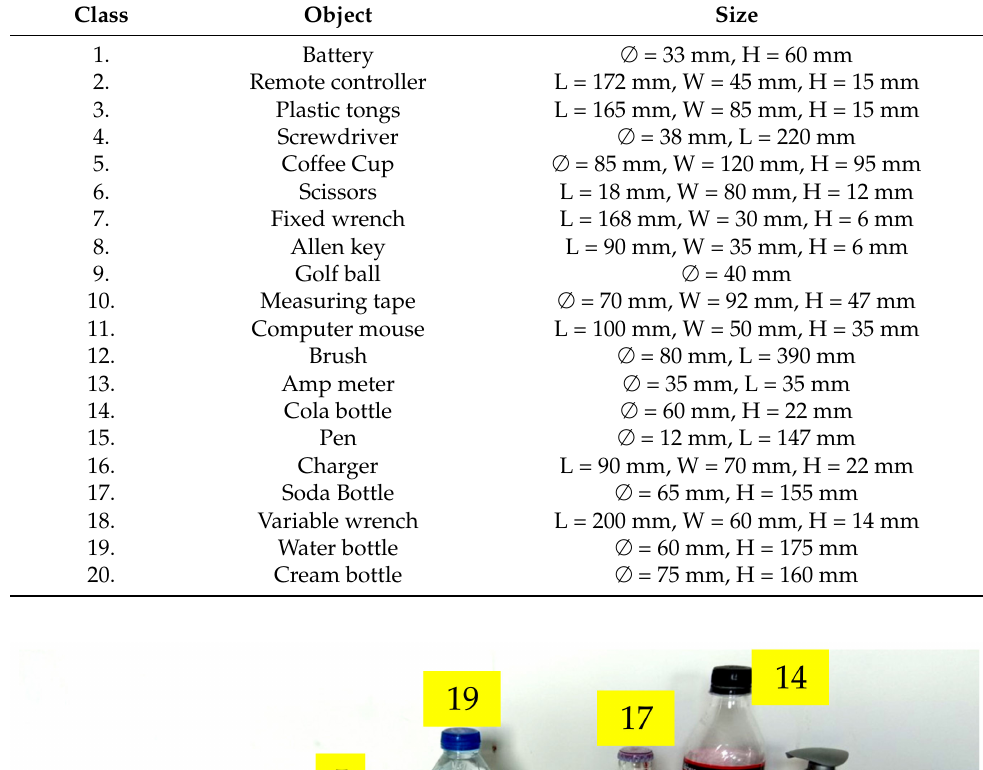
Table 3. Dimensions of objects used in the model training.